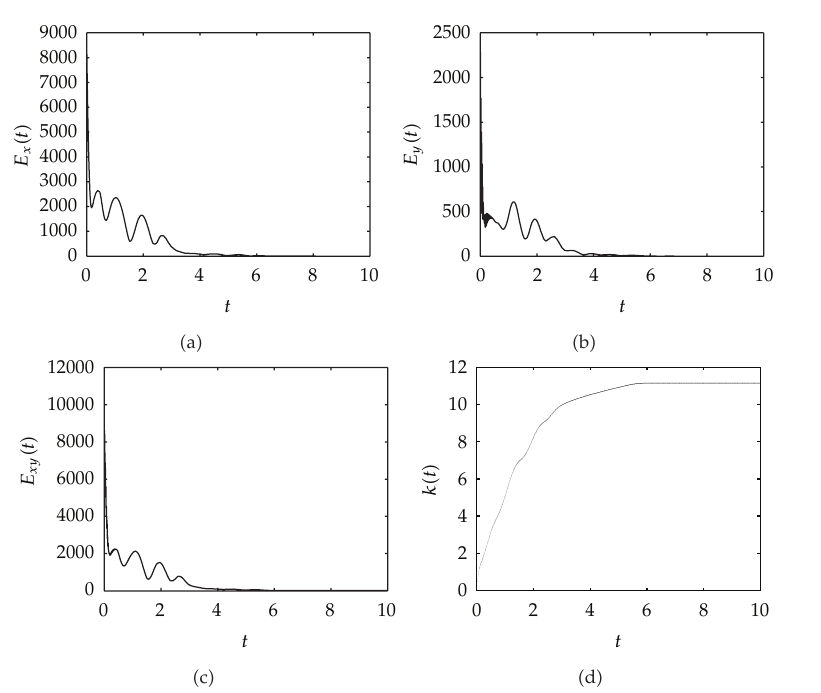
Figure 3: (cid:2) a (cid:3) , (cid:2) b (cid:3) , and (cid:2) c (cid:3) show the change process of E x , E y , and E xy with the adaptive control (cid:2) 3.32 (cid:3) ; (cid:2) d (cid:3) shows the change curve of the adaptive control